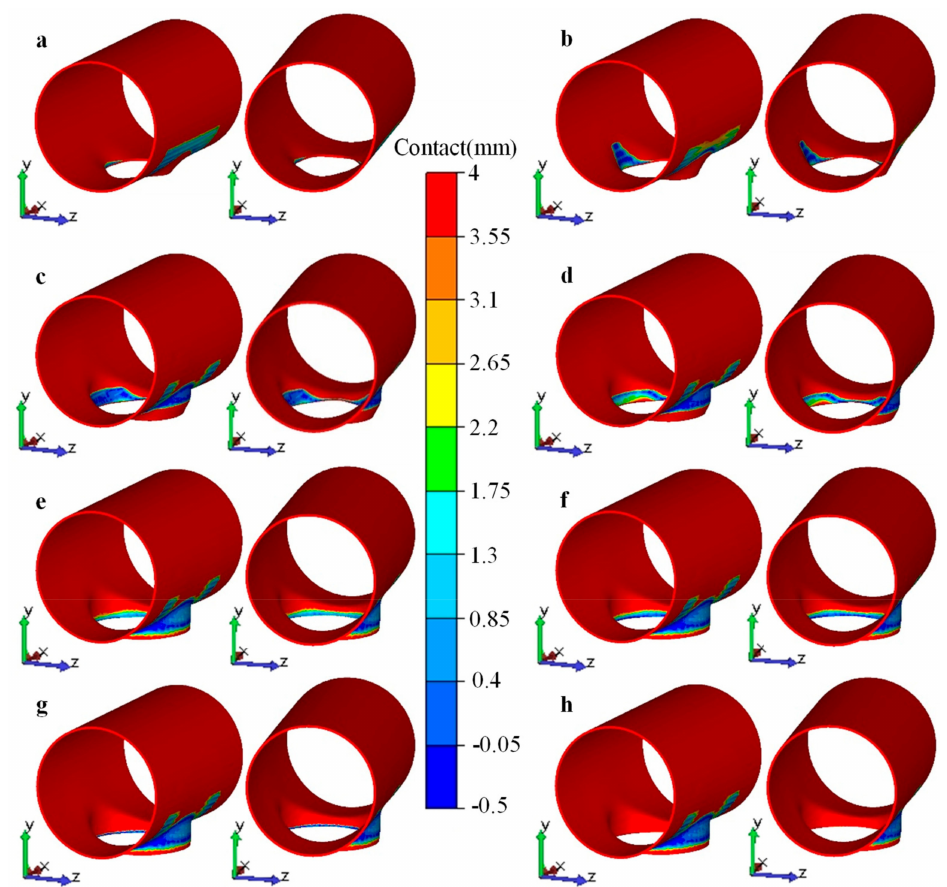
Figure 22. Contact between workpiece and upper / lower dies at chosen stages during flanging process, strokes of upper die were ( a ) 100 mm, ( b ) 200 mm, ( c ) 315 mm, ( d ) 350 mm, ( e ) 430 mm, ( f ) 440 mm, ( g ) 475 mm, ( h ) 500